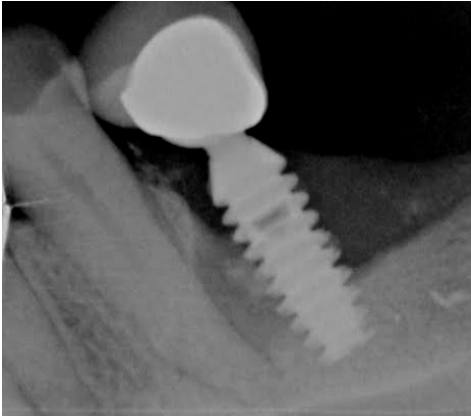
Figure 2. Image obtained during clinical practice of Dr. L. Fiorillo. Radiographic examination of implant with peri-implantitis due to the formation and organization of a biofilm on the implant surface. The interface between the bone tissue and the implant has been interrupted, this must be minimal and in the absence of biofilm to guarantee integration.